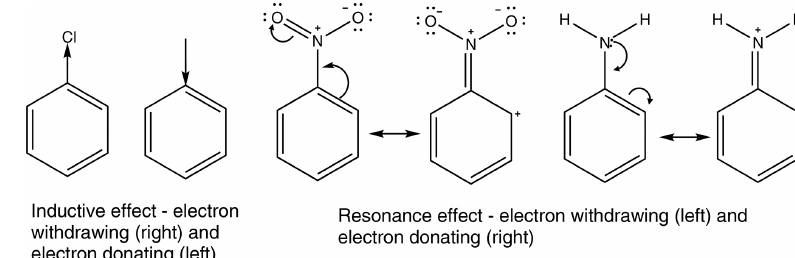
Figure 1. The inductive effect and the resonance effect.